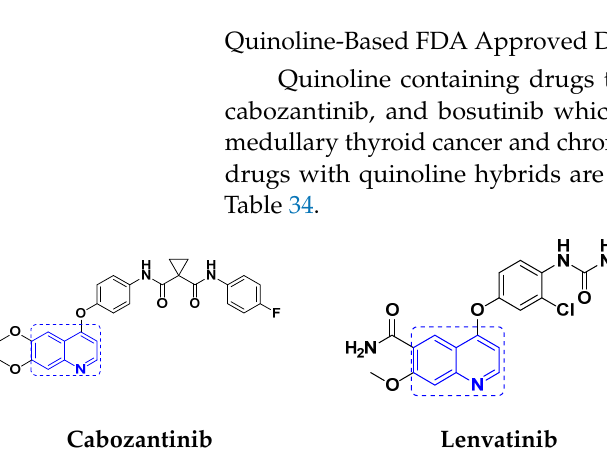
Figure 46. FDA approved drugs with quinoline hybrids. Table 34. Quinoline based FDA approved hybrids.